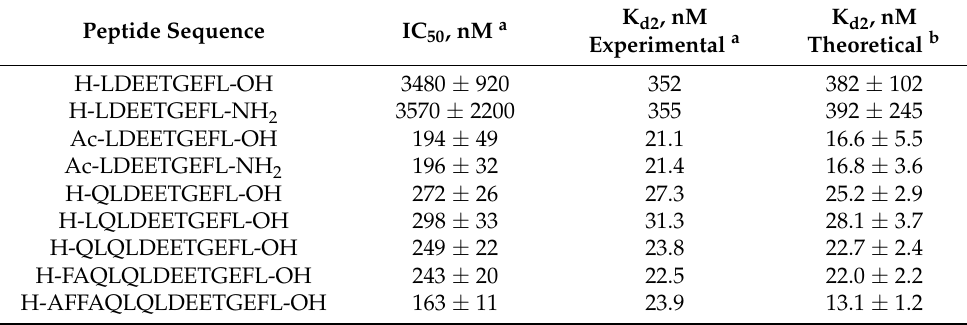
K d2 , nM K d2 , nM Experimental a Theoretical b